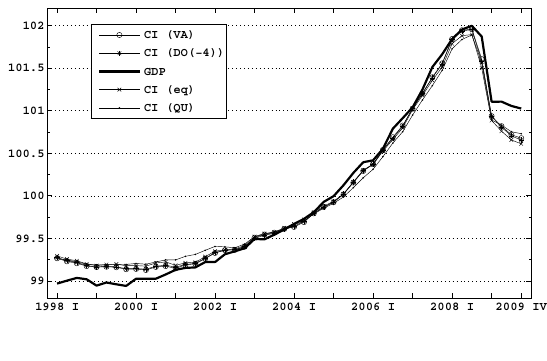
Figure 3. Different CI and GDP index.